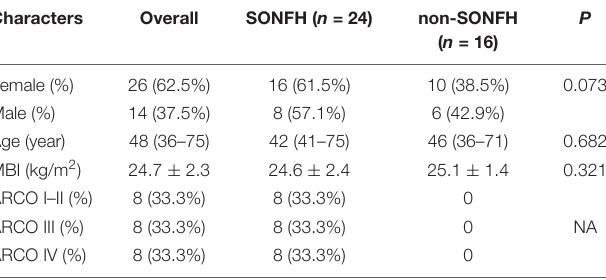
TABLE 1 | Baseline characteristics of the study